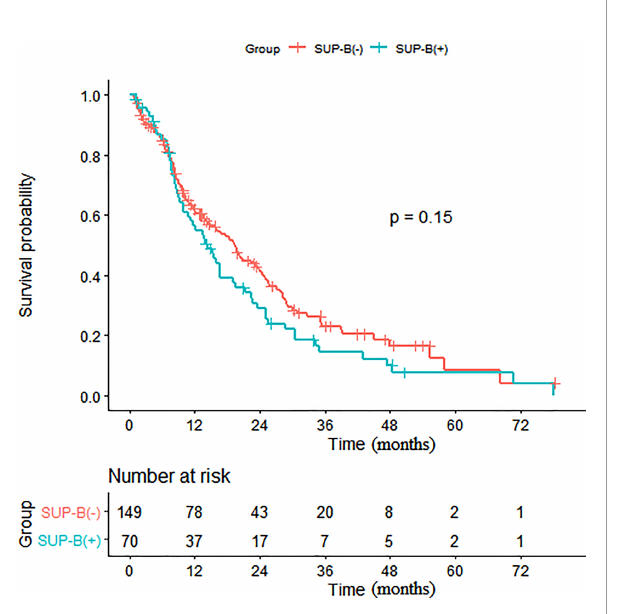
FIGURE 2 | Kaplan-Meier survival analysis of patients with and without SUP- B. (SUP-B, supraphrenic bone).